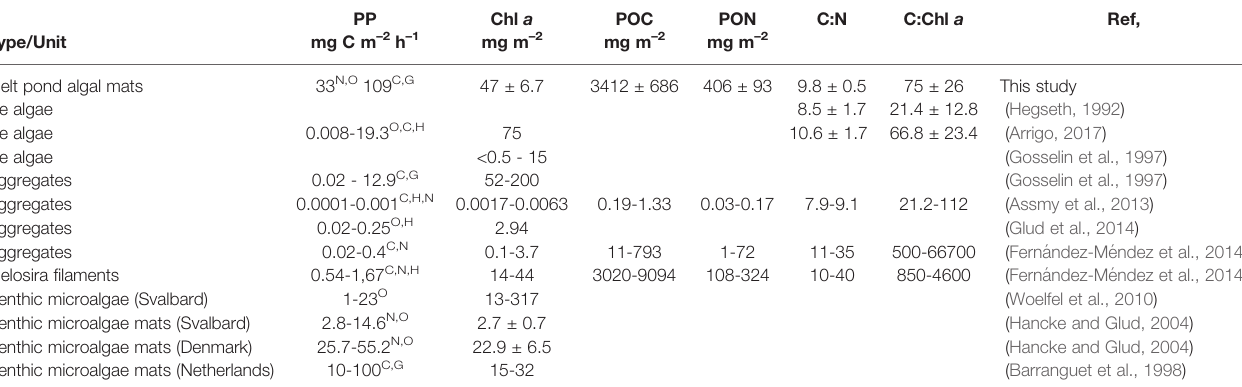
TABLE 1 | Primary production rates (gross or net), concentrations of Chl a , particulate organic carbon (POC) and nitrogen (PON), and ratios of C:N and C:Chl a in the present melt pond algae mat and previous reports for sea ice algae, ice algae aggregates, benthic algae, and microbial